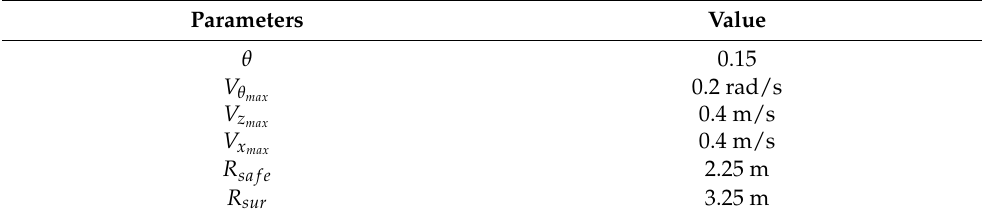
Table 4. Defined parameters for flight test.